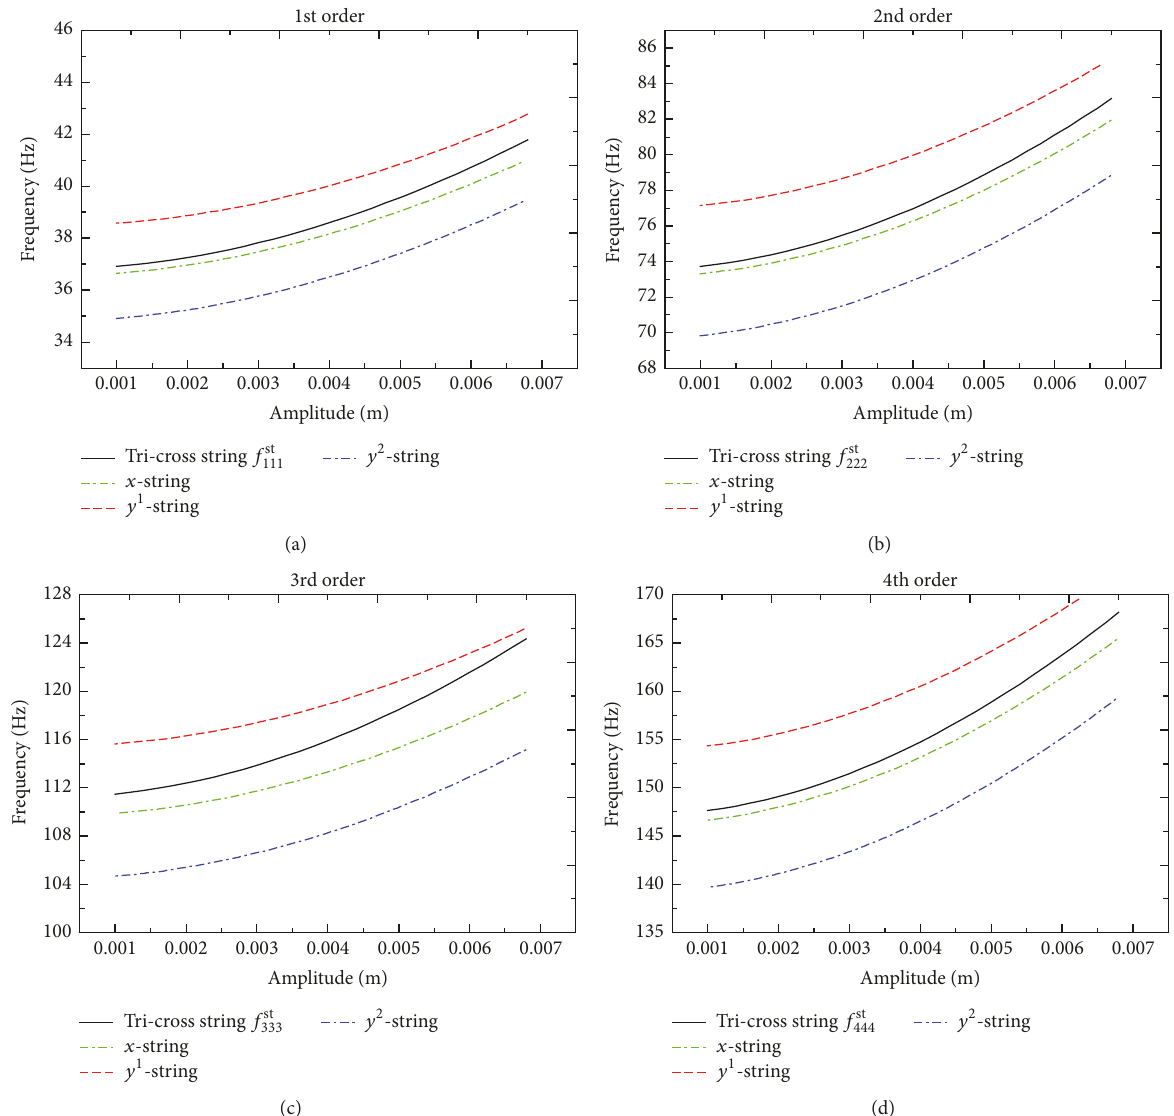
Figure 4: The influence of the vibration amplitude 𝑤 st (𝑥 = 0.5𝑙 0 ,𝑦 1 joint ,𝑦 2 joint , 0) on the first four frequencies of the strings: (a) the first mode 𝑓 st 𝑓 st 𝑓 st 111 , (b) the second mode 222 , (c) the third mode 333 , and (d) the fourth mode